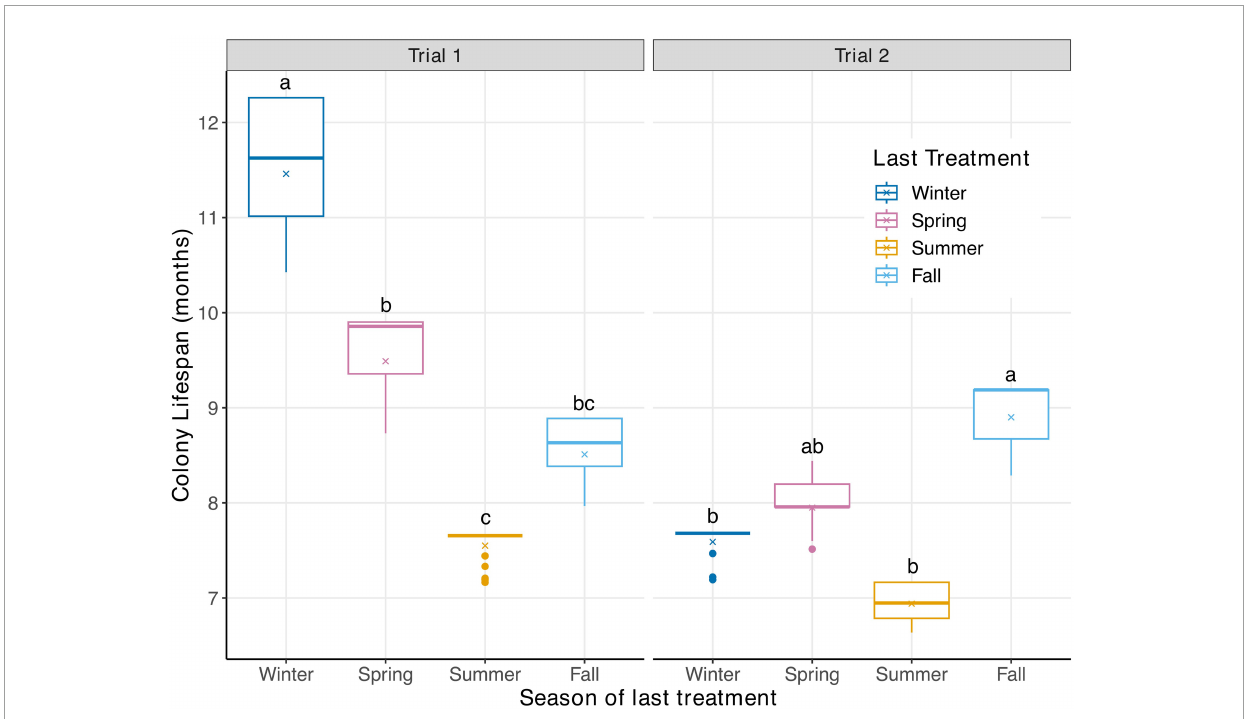
FIGURE3 Box plots illustrating the assumed lifespan distribution for colonies (in months) in the season in which treatment were applied for both trials. The × indicates the mean survival for colonies within that seasonal cohort. There was a significant impact of season the mite treatment was administered on colony lifespan within trial ( P ≤ 0.05). Post-hoc tests were performed within trial and significant differences between means are indicated with different letters ( α = 0.05; a > b >